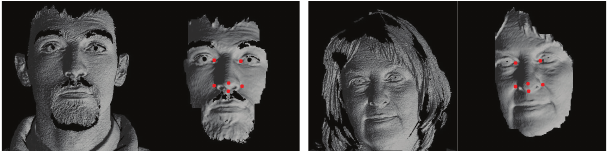
Fig. 6. Examples of face segmentation and landmarks detection processes.